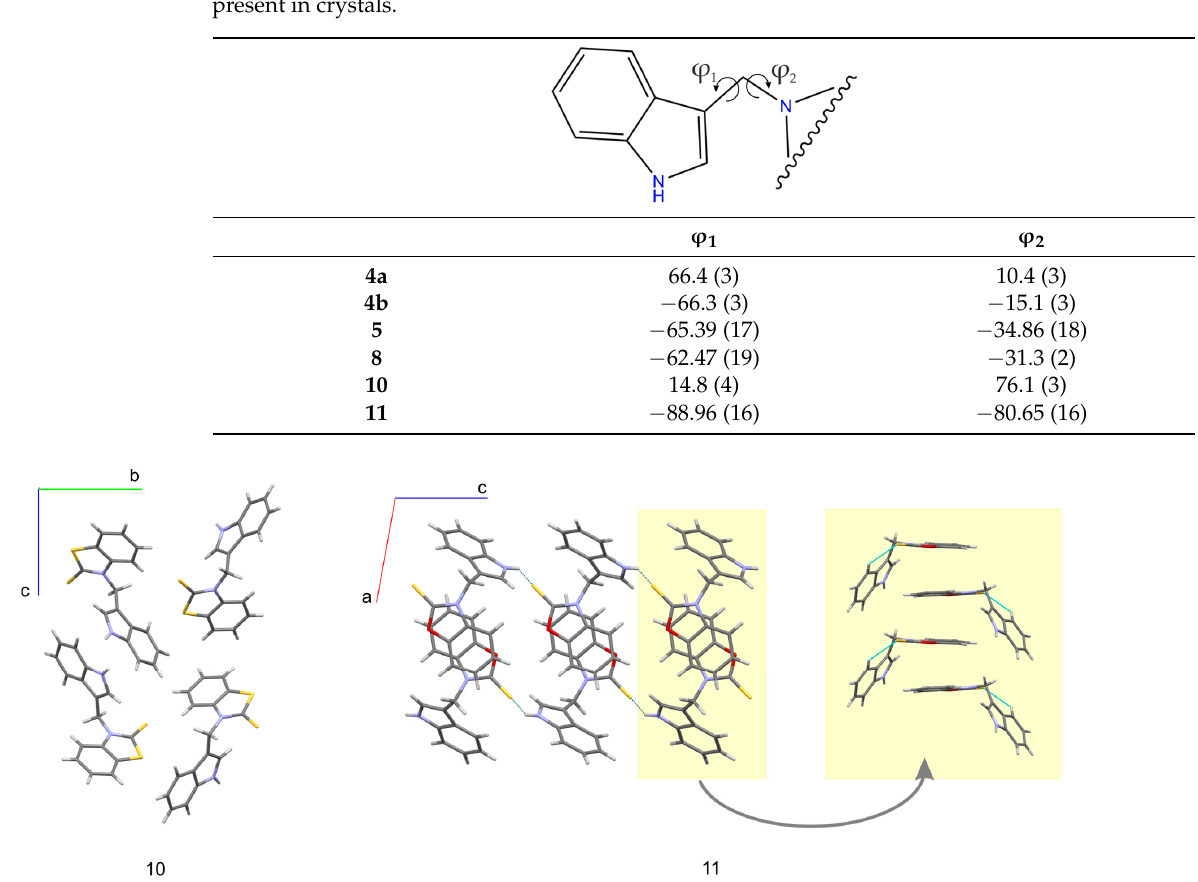
Figure 4. Effect of chalcogen exchange on the solid-state structures of 10 (view along [100]) and 11 (view along [010]). Table 2. Hydrogen bond parameters.